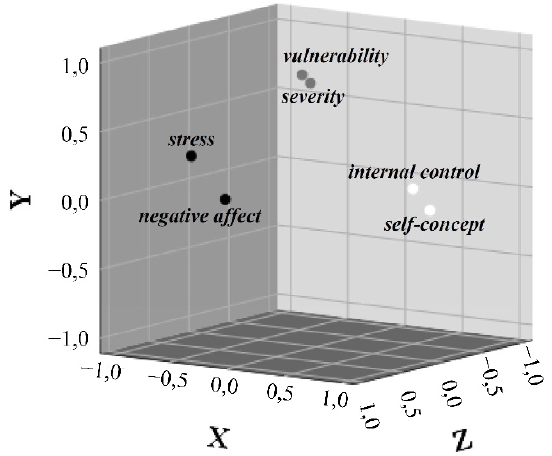
Figure 6. Component diagram in rotated space for the six central variables determined by factor analysis.